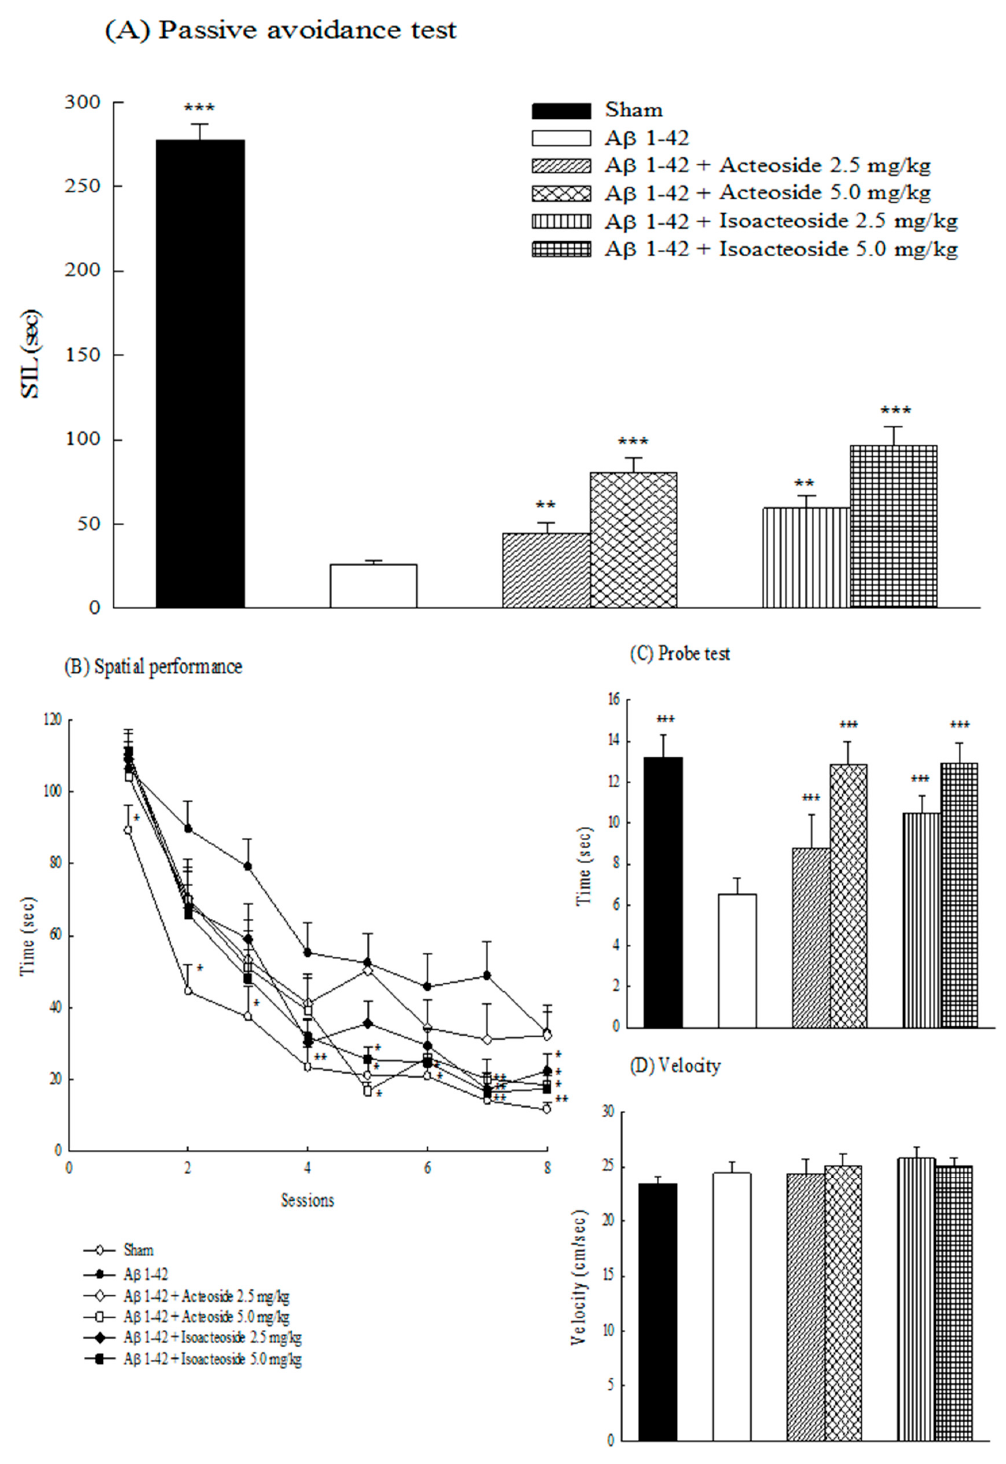
Figure 3. Effects of acteoside or isoacteoside (2.5, 5.0 mg/kg; po) on: ( A ) step-through latency (STL) of passive avoidance task; ( B ) spatial performance; ( C ) probe test; and ( D ) swimming velocity